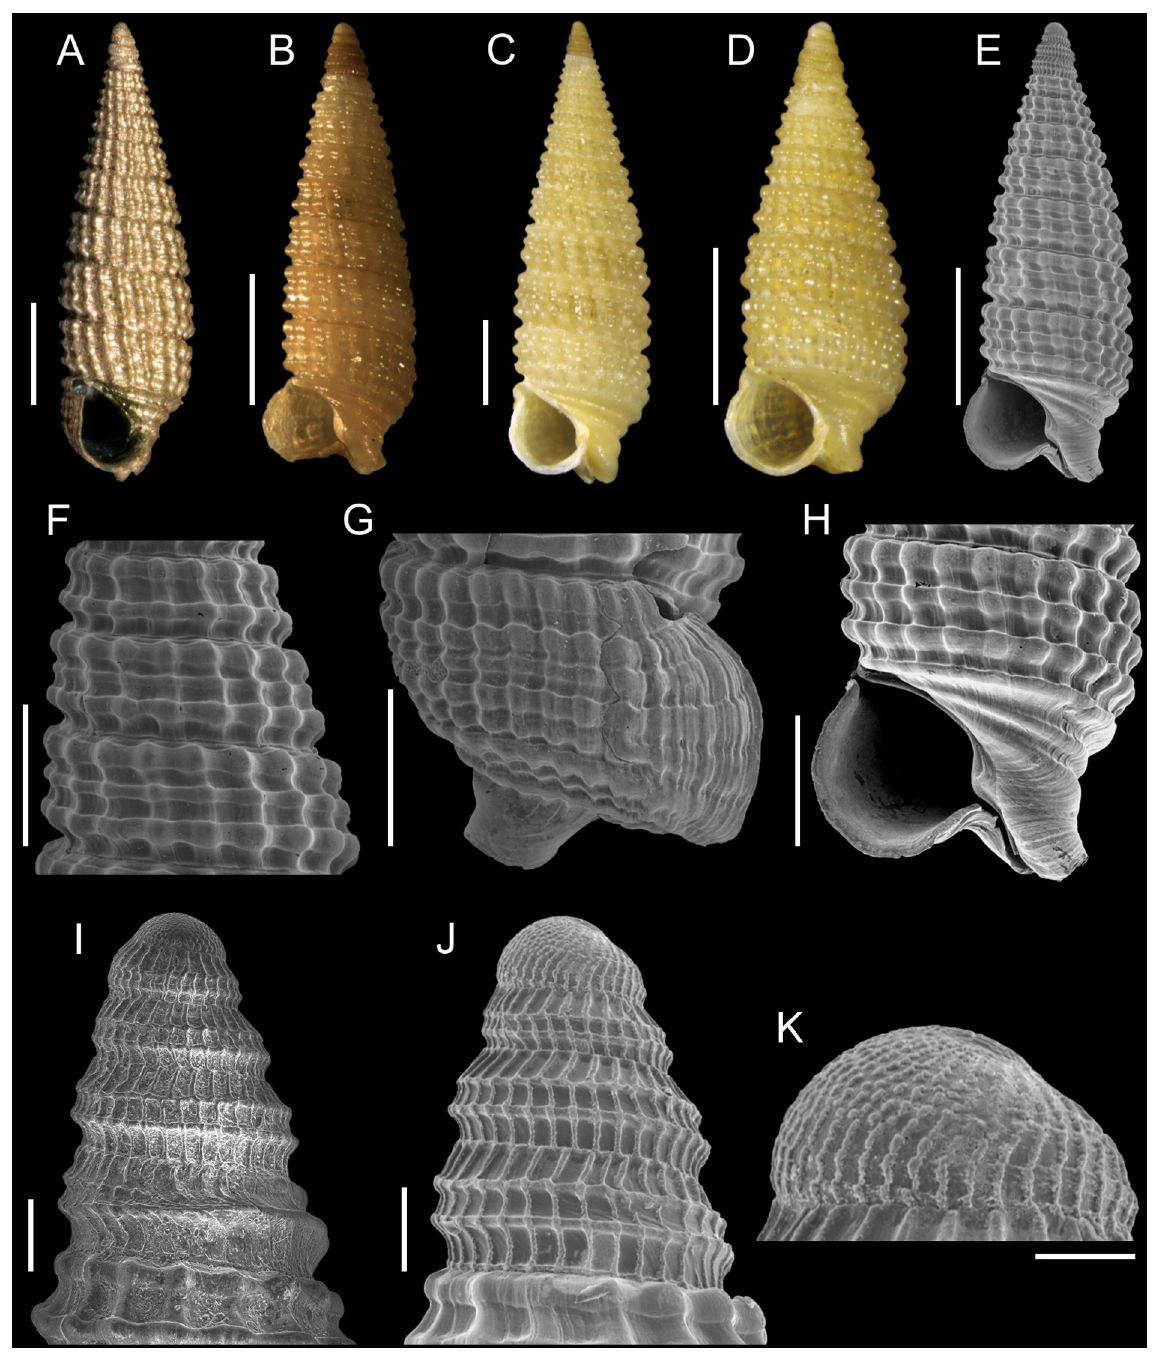
Fig. 93. Sagenotriphora osclausum (Rolán & Fernández-Garcés, 1995). A . Holotype, MNCN 15.05/17224. B . MNRJ 17956*, 3.46 mm. C . MNRJ 18964*, 5.48 mm. D . MNRJ 18946*, 2.91 mm. E . MNRJ 18381*, 3.35 mm. F–G . MNRJ 17970*. H, J–K . Same shell as E. I . Same shell as C. Scale bars: A–E = 1 mm; F–H = 500 µm; I–J = 100 µm; K = 50 µm . Photo credits A: Rafael Araujo (MNCN